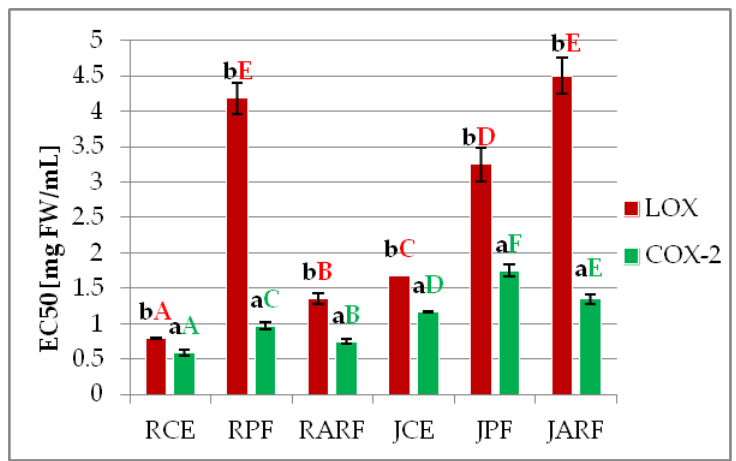
Figure 1. Anti-inflammatory activity of analyzed samples designated as LOX and COX-2 inhibitory activity — EC50 [mg FW/mL]. Abbreviations: RCE — raspberry crude extract, RPF — raspberry phenolic fraction, RARF — raspberry anthocyanin-rich fraction, JCE — raspberry juice crude extract, JPF — raspberry juice phenolic fraction, JARF — raspberry juice anthocyanin-rich fraction. Averages with different capital letters show significant differences between samples within one enzyme (red colour for LOX, green for COX-2) and with small letters show significant differences between enzymes (LOX and COX-2) inhibition by the same sample at p ≤ 0.05.